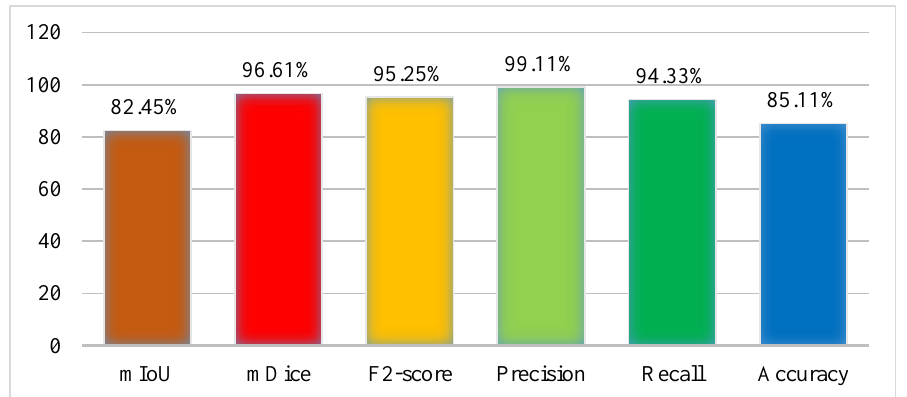
ure 6, which makes the results of the model more noticeable.